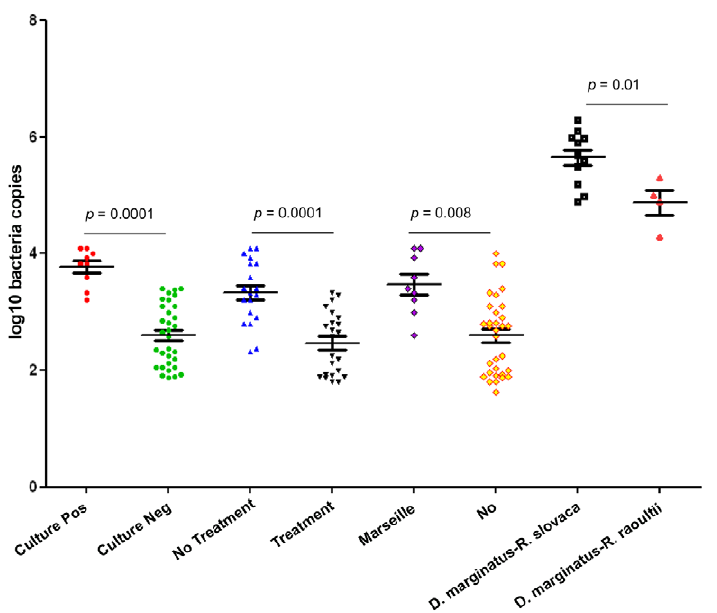
Figure 1. Comparison between the cycles and log10 values of the number of hypothetical protein copies/ml for R.africae .